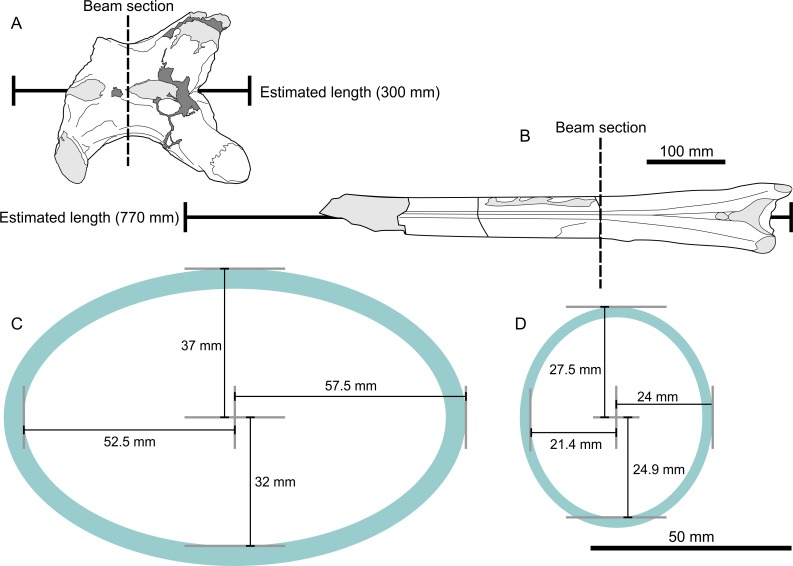
Metrics and cross sections used in estimates of bending strength analysis.(A) EME 315 in dorsal view showing line of modelled section (dotted line) and projected 300 mm length; (B) UJA VF1 in dorsal view showing line of section and projected 770 mm length (Frey & Martill, 1996); (C) cross section and dimensions of EME 315; (D) cross section of UJA VF1. Note difference in shape and bone wall thicknesses in (C) and (D).